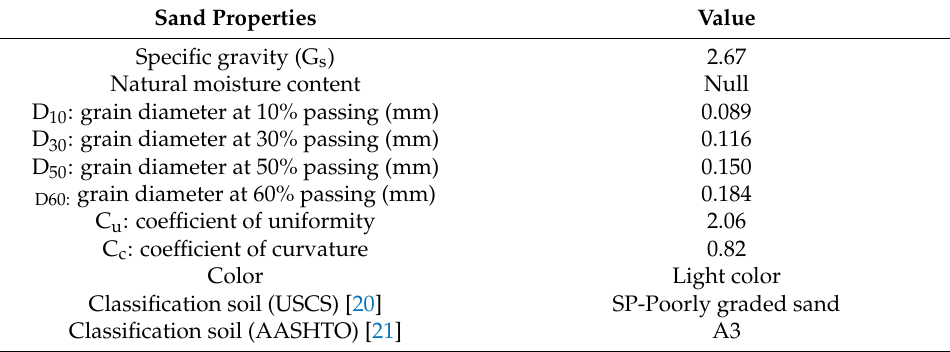
Table 2. Properties of tested sand